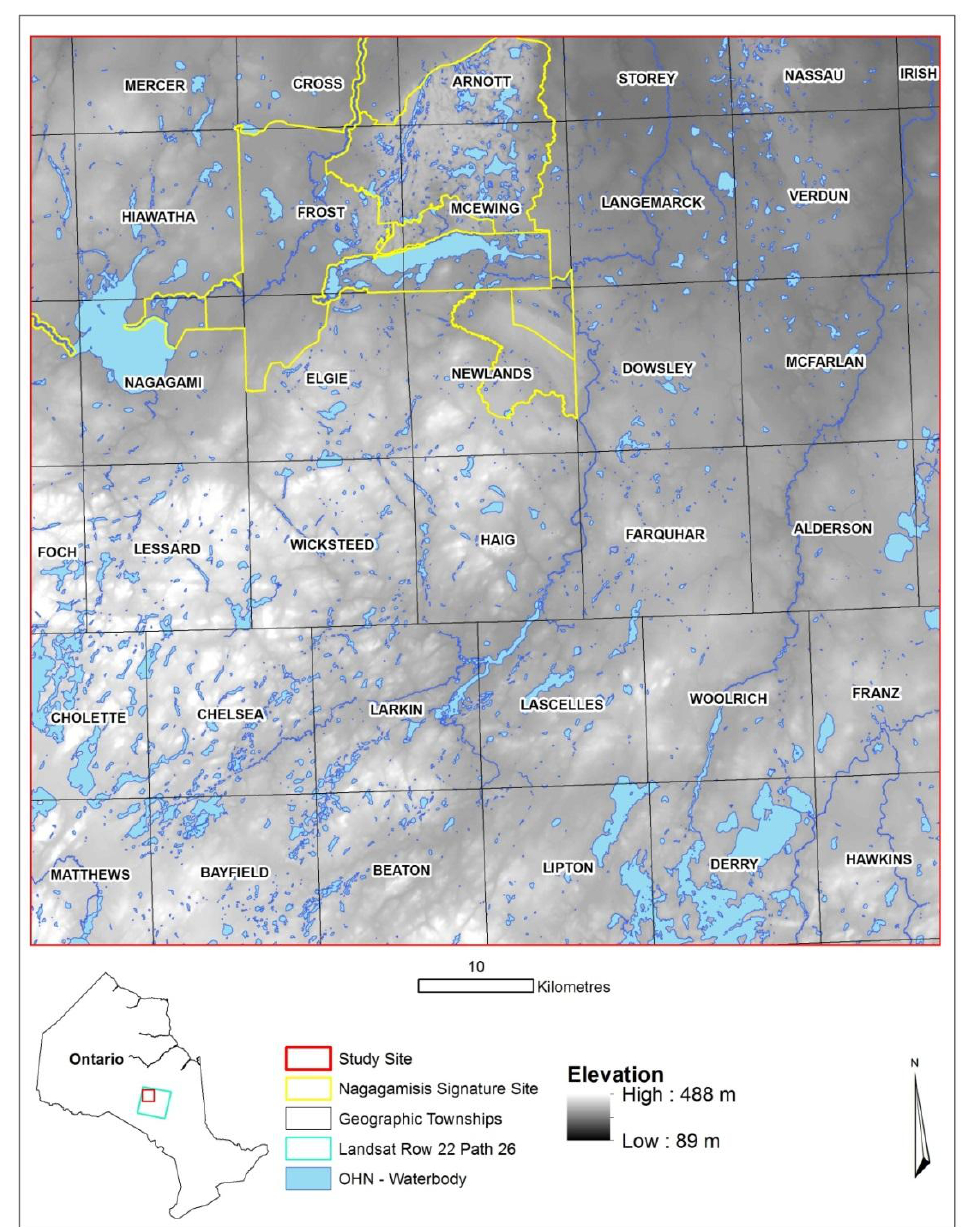
Figure 1. Study area location in the province of Ontario,